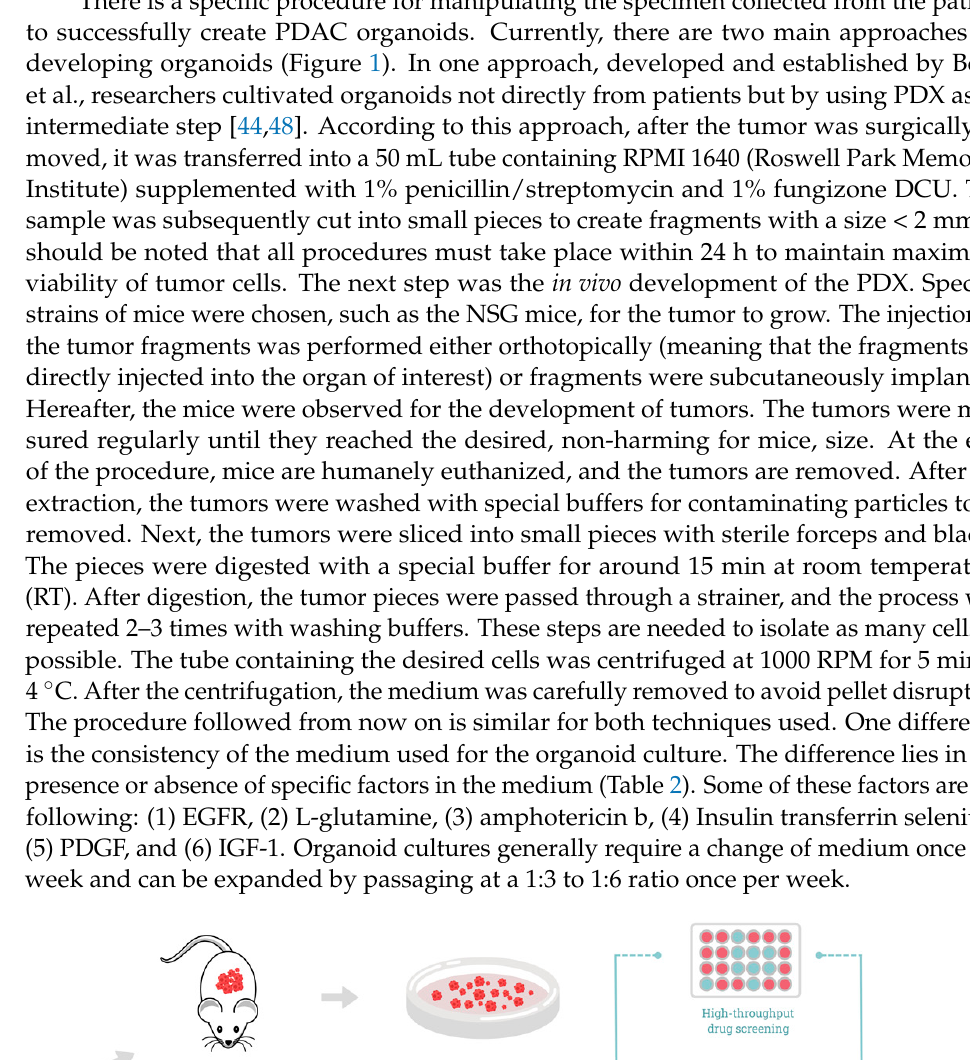
Table 2. Supplements used for human pancreatic organoid culture and their function.